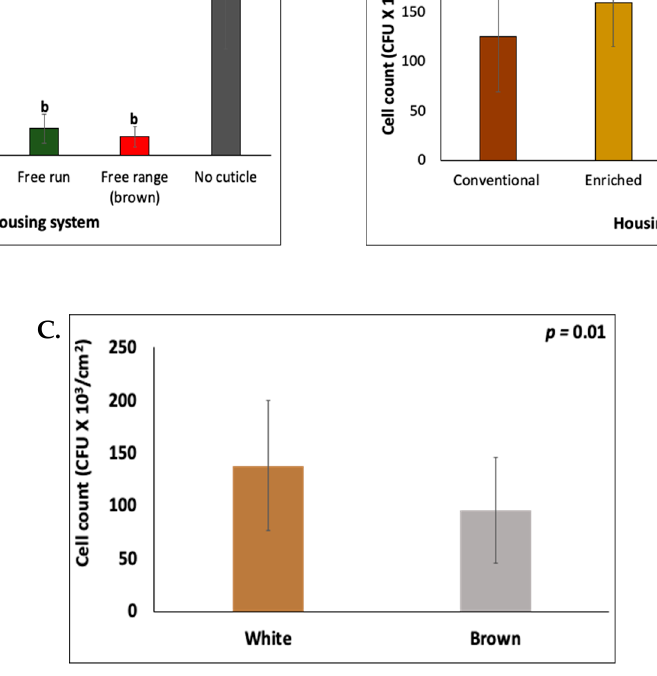
Figure 7. The bacterial cell attachment assay ( A ) The effect of the cuticle removal on Salmonella adherence on the eggshell surface. The Salmonella cell counts on the outer surface of the no cuticle (bleach-treated) eggshell were significantly higher than eggshells with an intact cuticle. ( B ) The impact of the different housing systems on Salmonella adherence to the eggshell surface. The values with different superscript letters (Tukey multiple means comparison) are significantly different (ANOVA; p < 0.05). The values represent the mean ± SD from six independent samples each performed in triplicate ( n = 3). ( C ) The impact of the hen strain on Salmonella adherence to the eggshell surface. The values represent the mean ± standard deviation ( n = 6 × 3 = 18, Student’s t -test; p < 0.05).